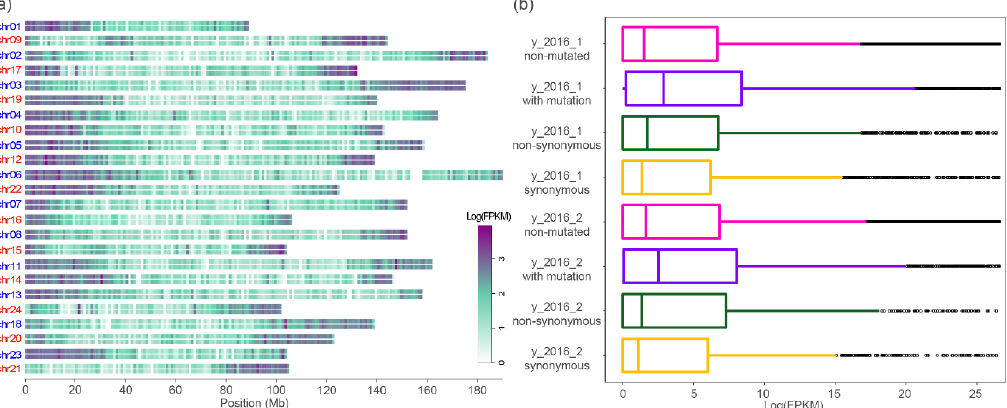
Figure 2. Genome-wide gene expression pattern and correlation with a genetic mutation. ( a ) The transcription level of the total genes along each of the 24 chromosomes. The two rows for each chromosome correspond to the sample y_2016_1 and y_2016_2, respectively; ( b ) comparisons between the overall gene expression levels and the types of genetic variants.